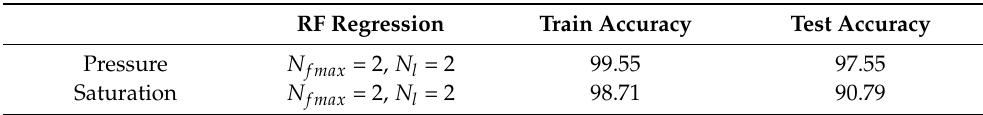
Table 5. Hyperparameters chosen by 5-fold cross-validation for Random Forest Regressor using 50 training